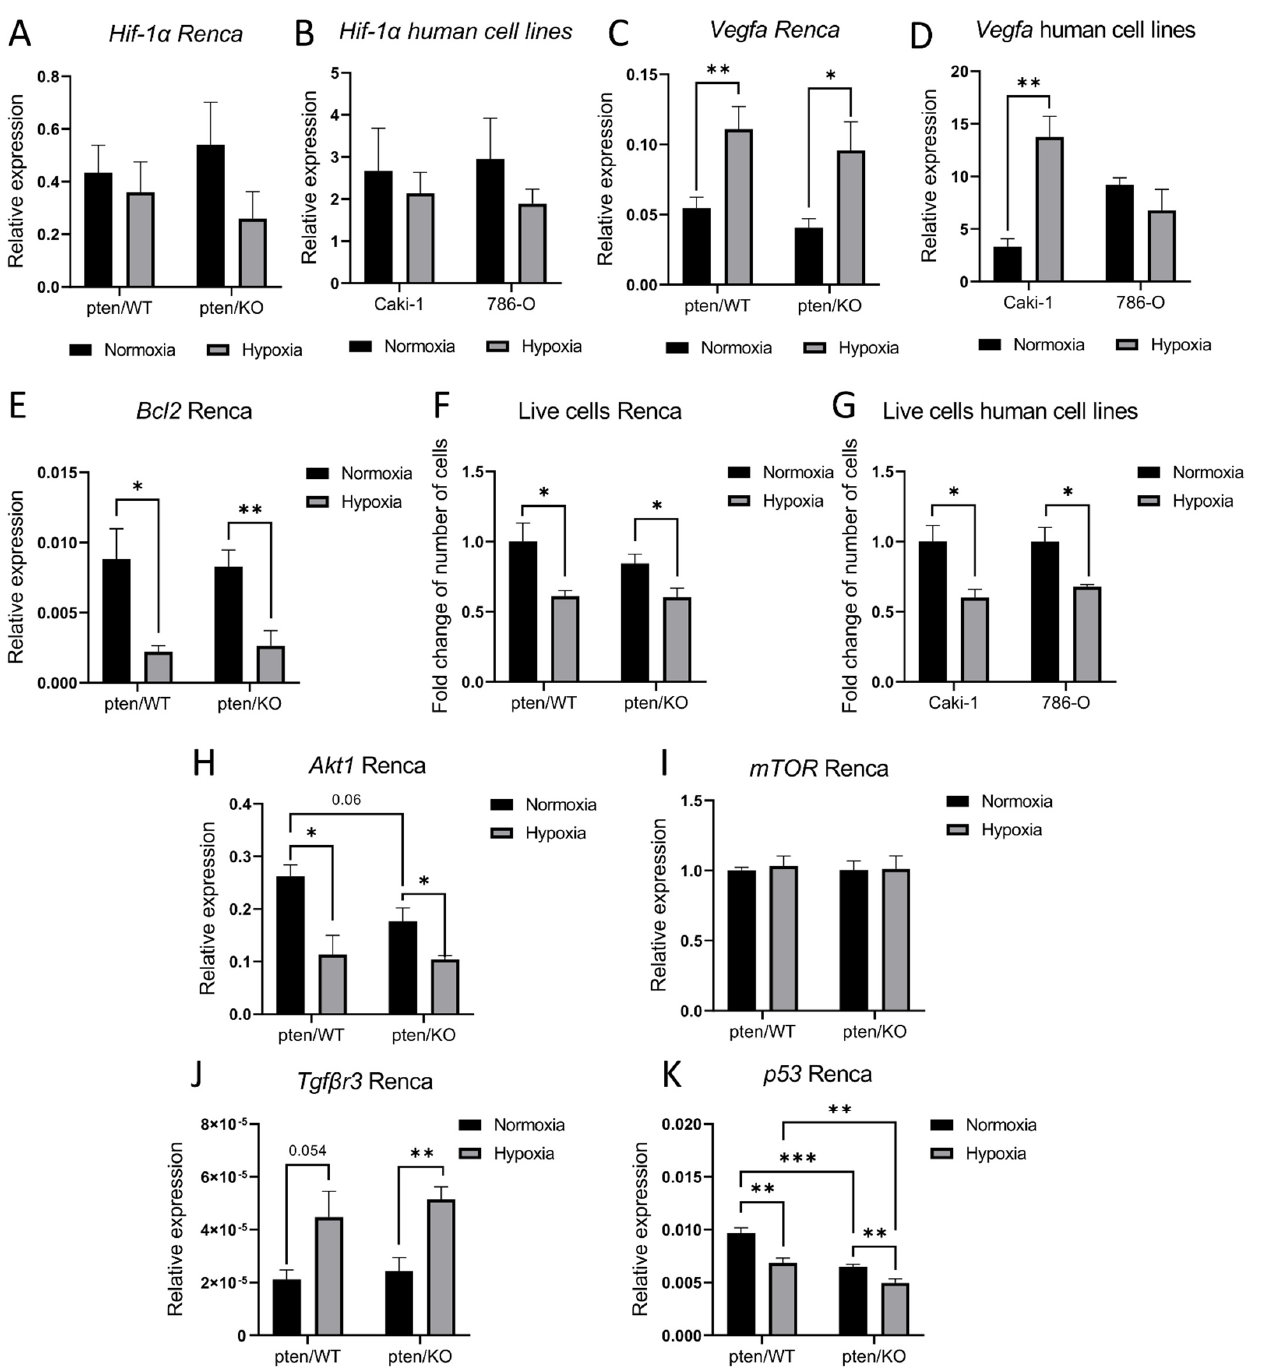
Figure 7. Expression of predicted target genes in RCC models ( A ) Relative to Actin β expression of Hif-1 α in Renca pten/WT ptenKO cells cultured in normoxia and hypoxia ( B ) Relative to GusB expression of Hif-1 α in Caki-1 and 786-O cells cultured in normoxia and hypoxia ( C ) Relative to Actin β expression of Vegfa in Renca pten/WT ptenKO cells cultured in normoxia and hypoxia ( D ) Relative to GusB expression of Vegfa in Caki-1 and 786-O cells cultured in normoxia and hypoxia ( E ) Relative to Actin β expression of Bcl2 in Renca pten/WT ptenKO cells cultured in normoxia and hypoxia ( F ) Fold change of number of live cells collected form normoxic and hypoxic culture: Renca pten/WT pten/KO ( G ) and Caki-1, 786-O ( H ) Relative to Actin β expression of Akt1 ( I ) mTOR ( J ) Tgf β r3 ( K ) p53 in Renca pten/WT ptenKO cells cultured in normoxia and hypoxia, Student’s t -test *** p -value < 0.001; ** p -value < 0.01; * p -value < 0.05.